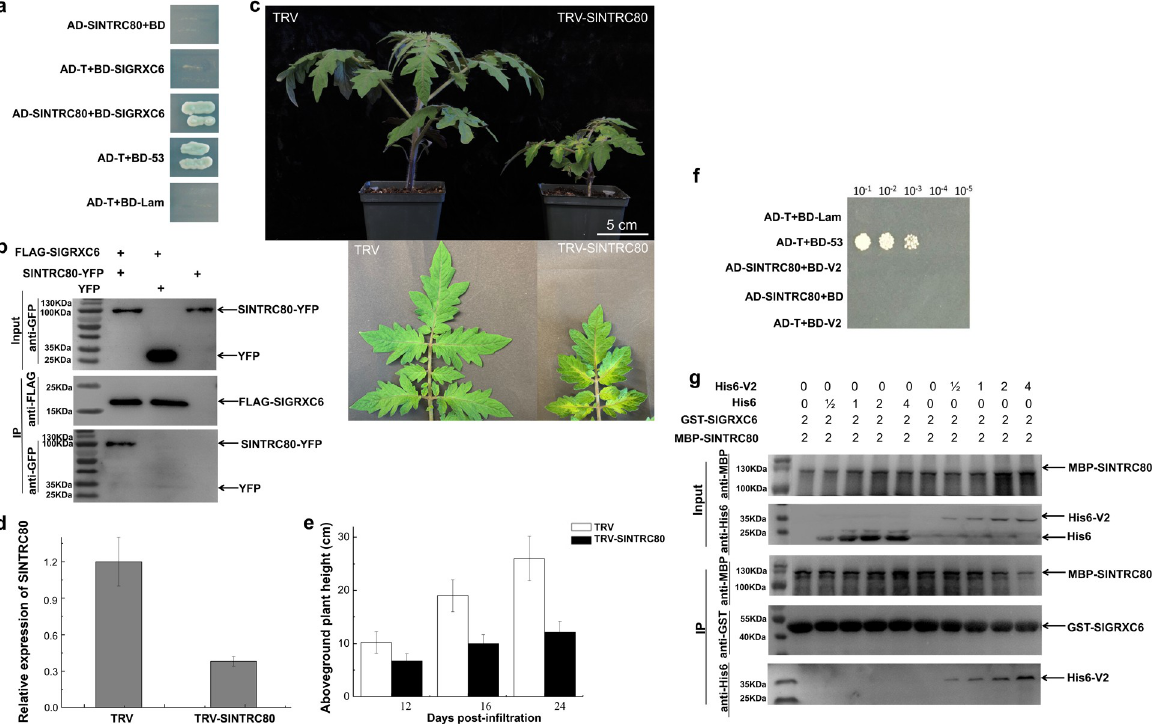
Fig 6. Identification of the interaction between SlGRXC6 and SlNTRC80. (a) The interaction between SlGRXC6 and SlNTRC80 was tested in the Y2H. Yeast cells expressing the indicated pairs of proteins grew on selection medium (SD/- His/-Leu/-Trp/-Ade) supplied with X- α -Gal. (b) The SlGRXC6-SlNTRC80 interaction was confirmed by co-IP assay. (c) Tomato plants treated with TRV or TRV-SlNTRC80. Plants and newly emerged systemic leaves were photographed at 12 dpai. Bar: 5 cm. Experiments were repeated three times with similar results. (d) Relative expression of SlNTRC80 was tested in control and SlNTRC80 -silenced plants using qRT-PCR as shown in Fig 2A. Data are means ± SD (n = 3). (e) Aboveground plant heights of control and SlNTRC80 -silenced plants at 12, 16, and 24 dpai. (f) The interaction between V2 and SlNTRC80 was tested in Y2H. Yeast cells expressing the indicated pair of proteins were plated onto the selection medium (SD/-His/-Leu/-Trp) in 10-fold serial dilutions. (g) In vitro competitive pulldown assays. The indicated amounts of His6-V2 or His6 protein were mixed with 2 μ g of MBP-SlNTRC80 and pulled down by 2 μ g of GST-SlGRXC6. The bound protein was detected by immunoblotting with the indicated antibodies. Experiments were repeated three times with similar